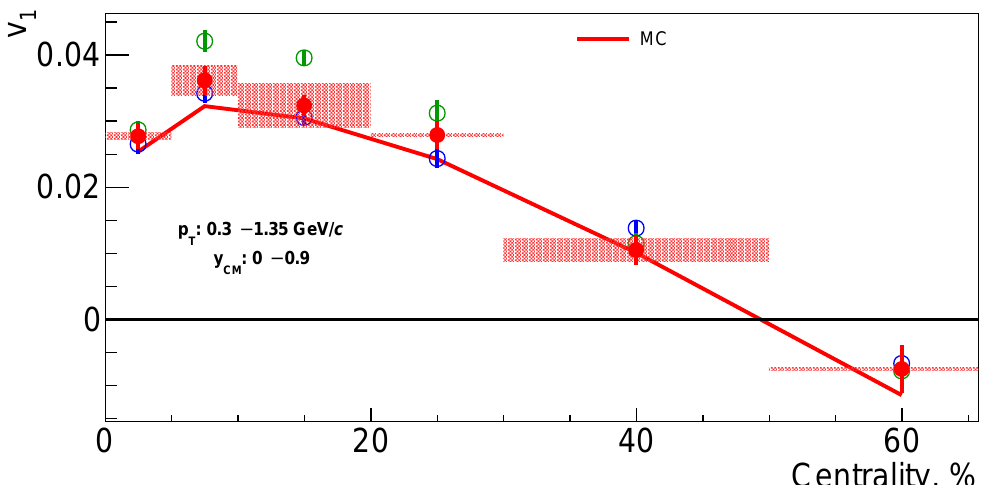
Figure 5. Directed flow v 1 of Λ hyperons as a function of ( top ) rapidity for minbias collisions, 0.3 < p T < 1.35 GeV / c , ( middle ) transverse momentum for minbias collisions, 0 < y CM < 0.9, and ( bottom ) centrality, 0.3 < p T < 1.35 GeV / c , 0 < y CM <